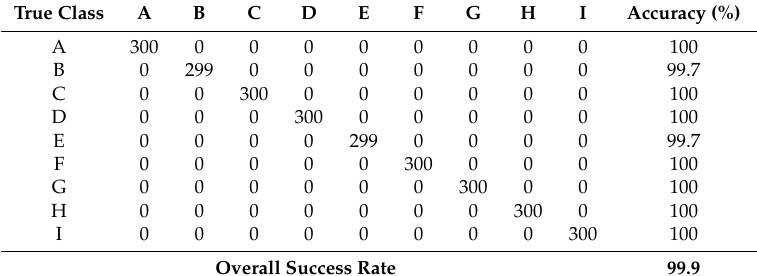
Table 4. Artificial neural network (ANN) Classification accuracy for power quality disturbance (PQD) signals with